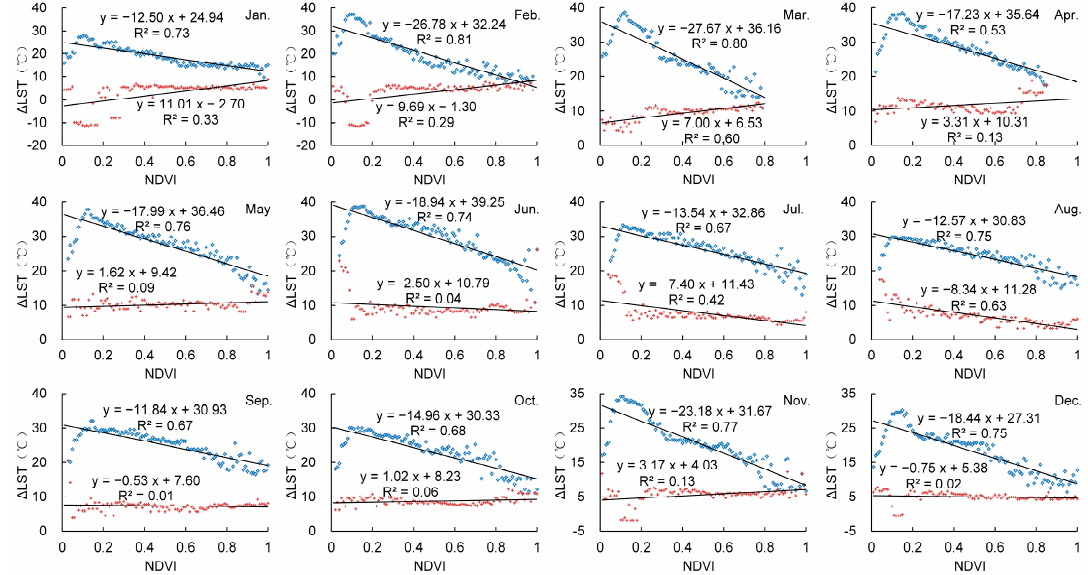
Figure 4. The monthly dry (blue)/wet edges (red) and their fitting equations derived from scatterplots of NDVI and ∆ LST in 2005